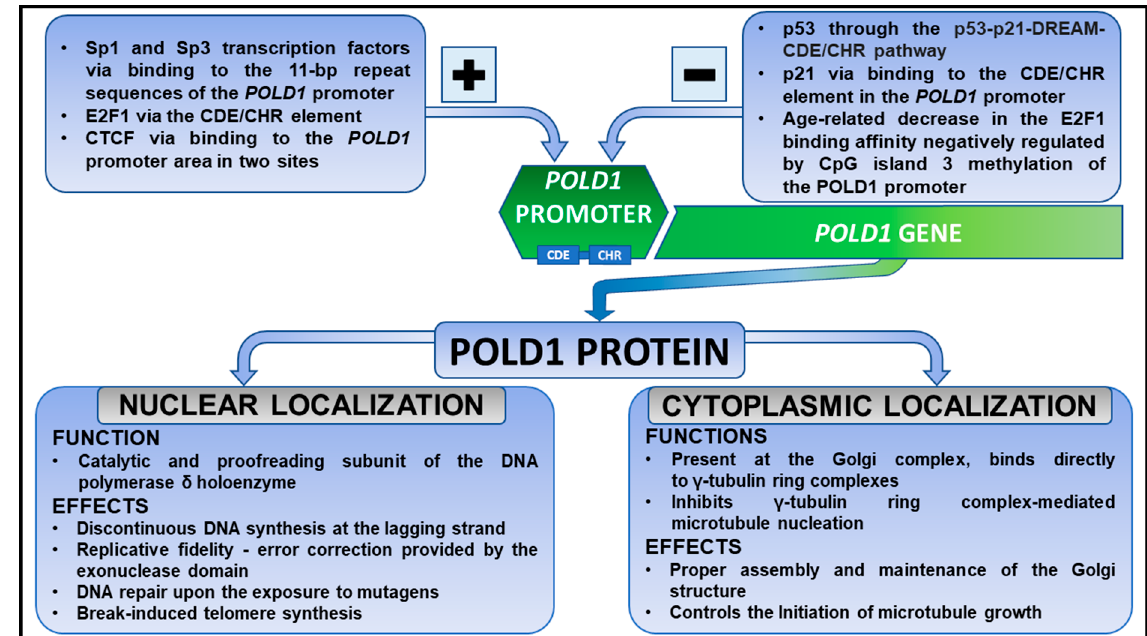
Figure 1. Regulation of POLD1 gene expression within the cell and physiological roles of POLD1 depending on its cellular localization. The figure highlights positive and negative regulators of the POLD1 promoter. Apart from well-known functions of POLD1 exhibited in the nucleus, recent studies have also noticed its role within the cytoplasm. bp, base pair; CDE/CHR, cycle-dependent element/cell cycle gene homology region; CTCF, CCCTC-binding factor; DREAM, dimerization partner, RB-like, E2F, and MuvB core complex.